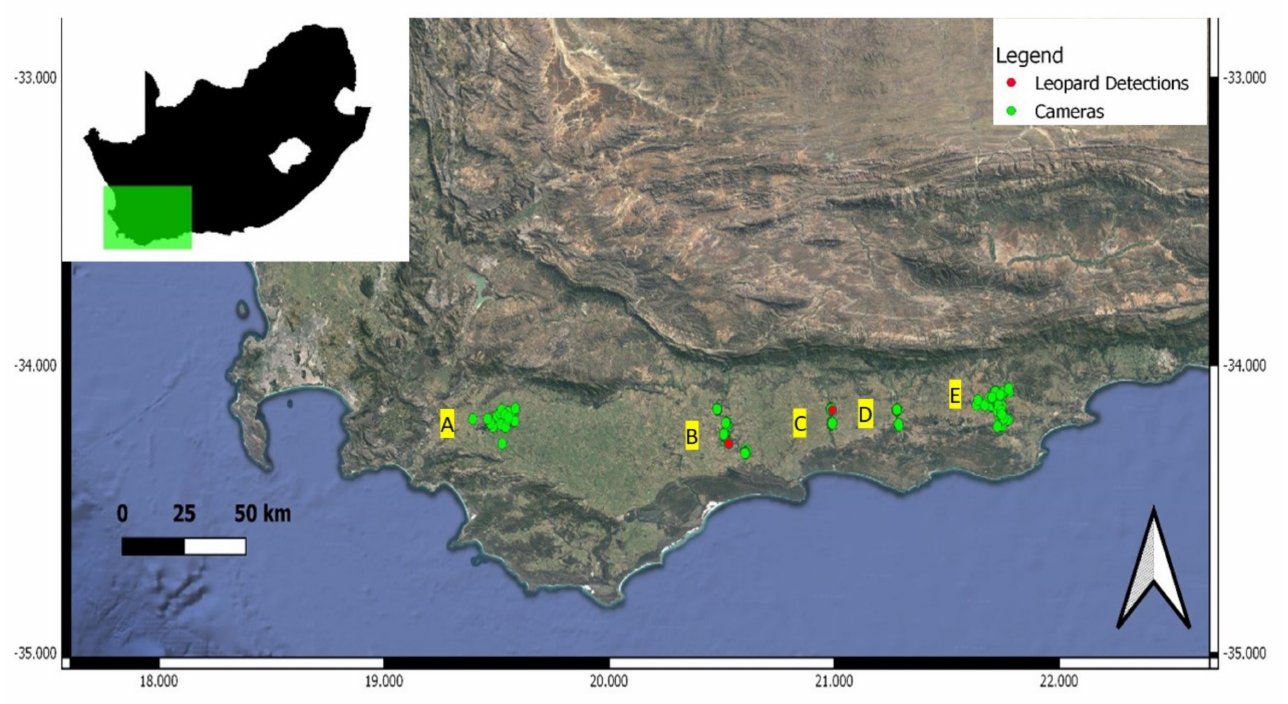
Figure 3. Five potential corridors, ( A ) Klein Swartberg, ( B ) Breede 1 and 2 ( C ), Duiwenhoks ( D ), Goukou, and ( E ) Gourits, tested for functionality using camera traps (green). Two corridors detected leopard presence (red). The insert indicates the location of the study (green shaded area) within South